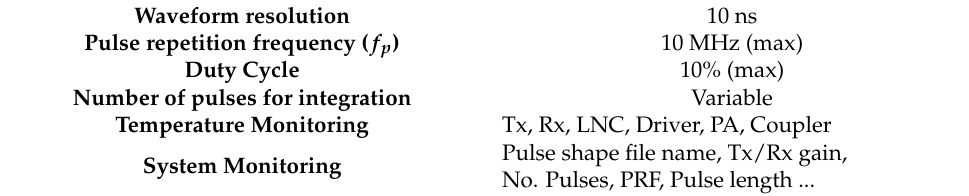
Table 5. Controller board